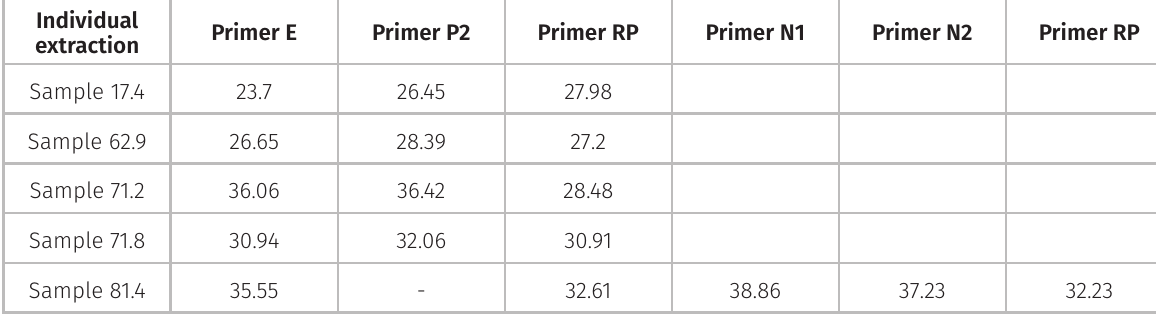
Table II. SARS-CoV-2 individual samples positive for SARS-CoV-2. Out of 37 samples analyzed five were positive for SARS-CoV-2. One pool displayed two positive samples 71.2 and 71.8 (Pool 71). Sample 81.4 was only considered positive after N1 and N2 genes were targeted by RT-qPCR. “-“ are undetermined values. Individual